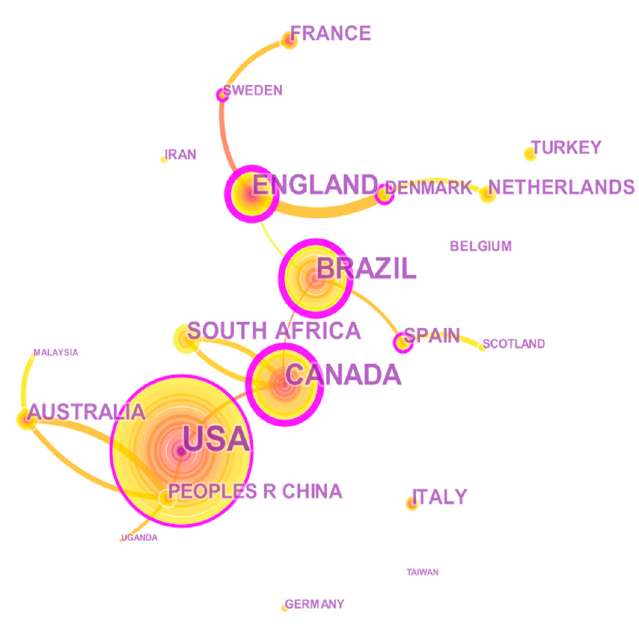
Figure 3. International collaboration network.